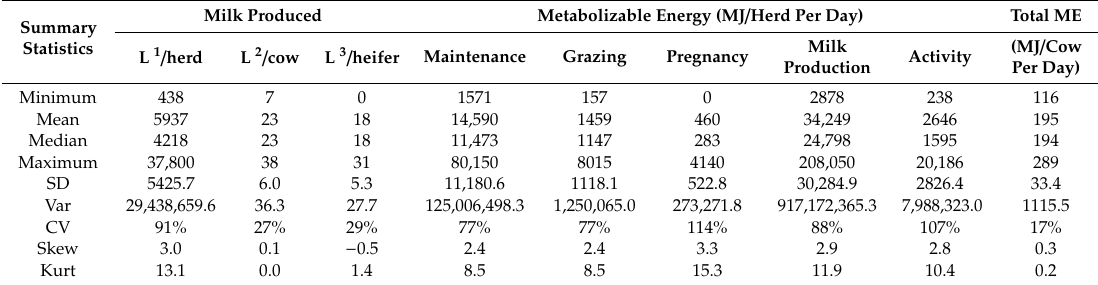
Table 2. Summary statistics of milk volume produced by the herd, and calculated per lactating cow and per heifer, the calculated herd metabolizable energy (ME) required for maintenance, grazing, pregnancy, milk production, activity, and total ME per cow for lactating cows at five occasions on 43 farms ( n =